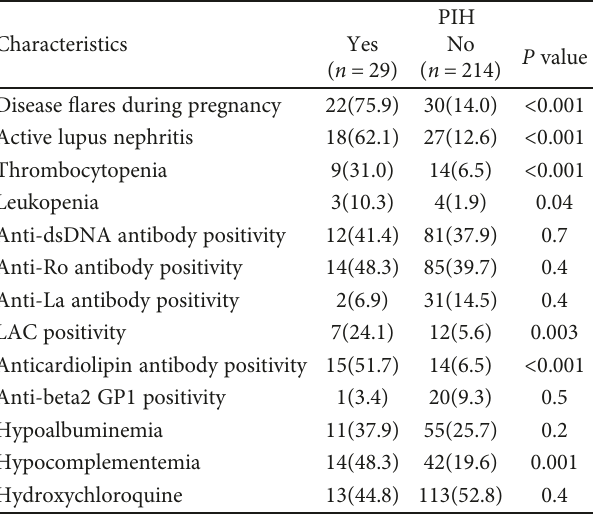
Table 5: Univariate analysis of variables associated with adverse maternal